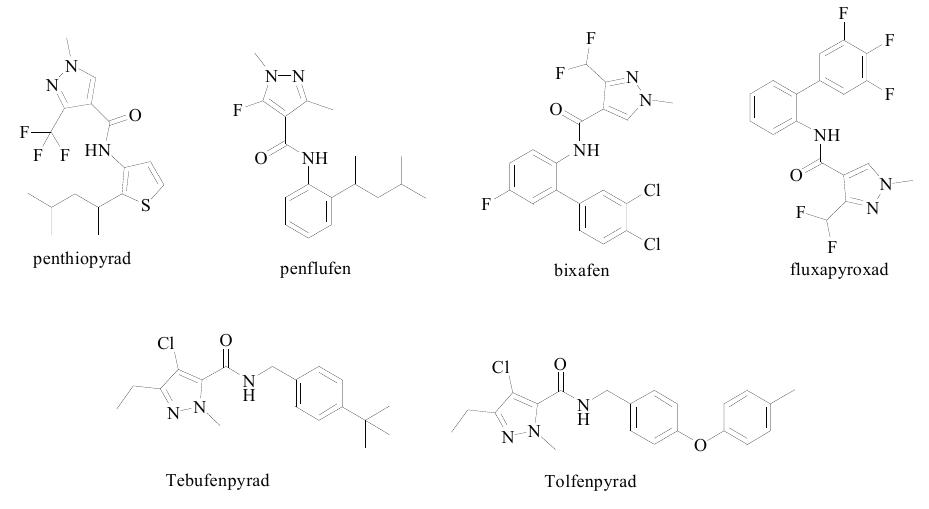
Figure 1. Pyrazole derivative